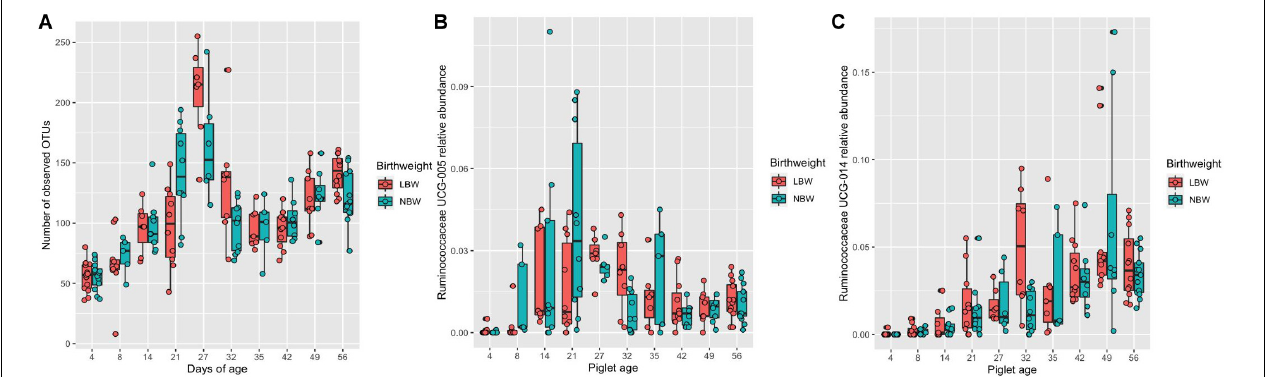
FIGURE 2 | Box and whisker plots demonstrating the changes in (A) the number of observed OTUs, (B) the abundance of Ruminococcaceae UCG-005, and (C) the abundance of Ruminococcaceae UCG-014 associated with piglet age and the interaction with birthweight class [low (LBW) or normal (NBW)]. (A) Significant pairwise differences in observed OTUs associated with the interaction between birthweight classes and piglet age are identified by differences in the assigned Tukey HSD letters: days 4LBW a , 4NBW ab 8LBW b , 8NBW bc , 14LBW cd , 14NBW d , 21LBW d , 21NBW g , 27LBW h , 27NBW g , 32LBW fg , 32NBW d , 35LBW d , 35NBW d , 42LBW d , 42NBW de , 49LBW ef , 49NBW ef , 56LBW g and 56NBW f . (B) . Significant differences in Ruminococcaceae UCG-005 abundance associated with increasing piglet age and the interaction with birthweight classes (LBW or NBW) are identified by differences in the assigned Tukey HSD letters: days 4LBW ab , 4NWB a ,